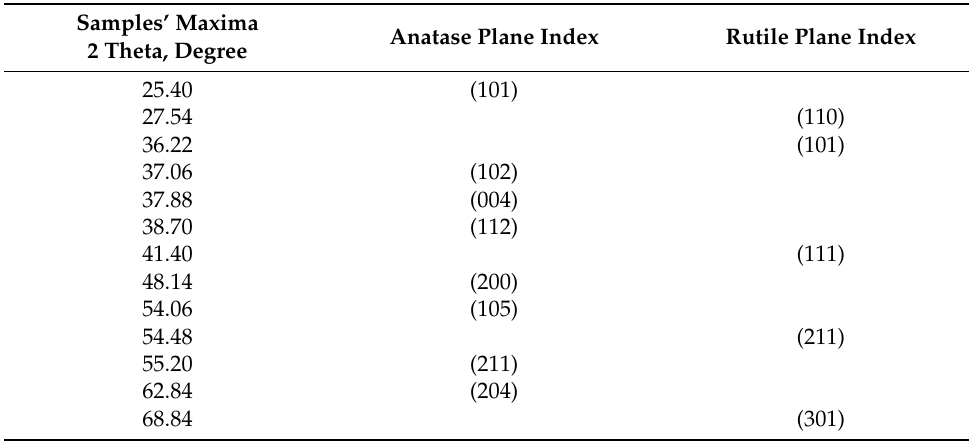
Figure 2. XRD patterns for the samples. Table 1. Assignment of the signals from